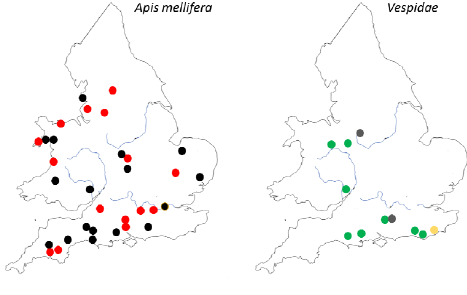
Figure 1. Presence of Moku virus (MV) in England, Wales, and Jersey, where red dots are locations of A. mellifera MV-positive colonies and black are MV-negative (where multiple colonies were sampled from the same site, detection in 1+ colonies have been displayed as positive). Yellow is the location of MV-positive V. crabro, green is MV-positive V s. vulgaris , purple is MV-positive V. velutina (Jersey), and grey is the locations of MV-negative vespid samples.